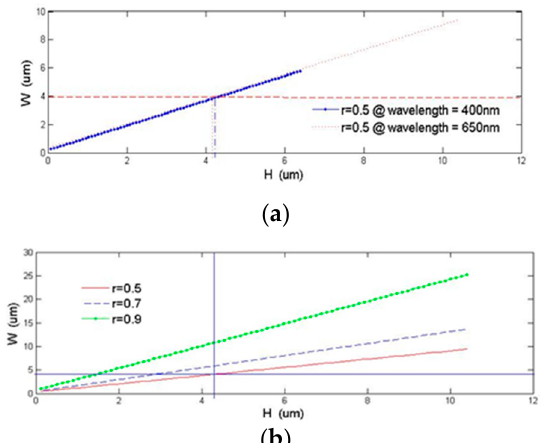
Figure 10. Waveguide width as a function of waveguide height at ( a ) λ = 400 and 650 nm and ( b ) at different r values at λ = 650 nm.